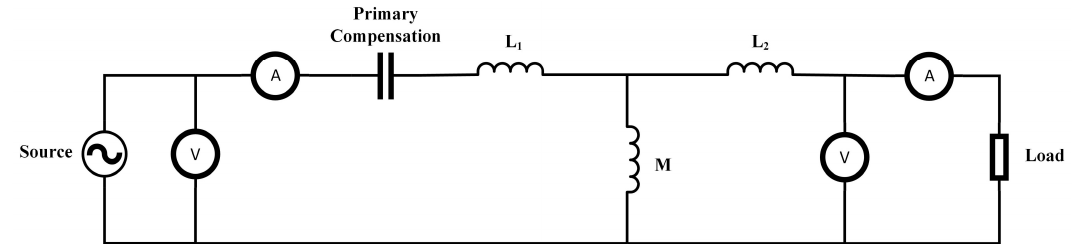
Figure 10. Electric circuit: primary compensation with resistive load.